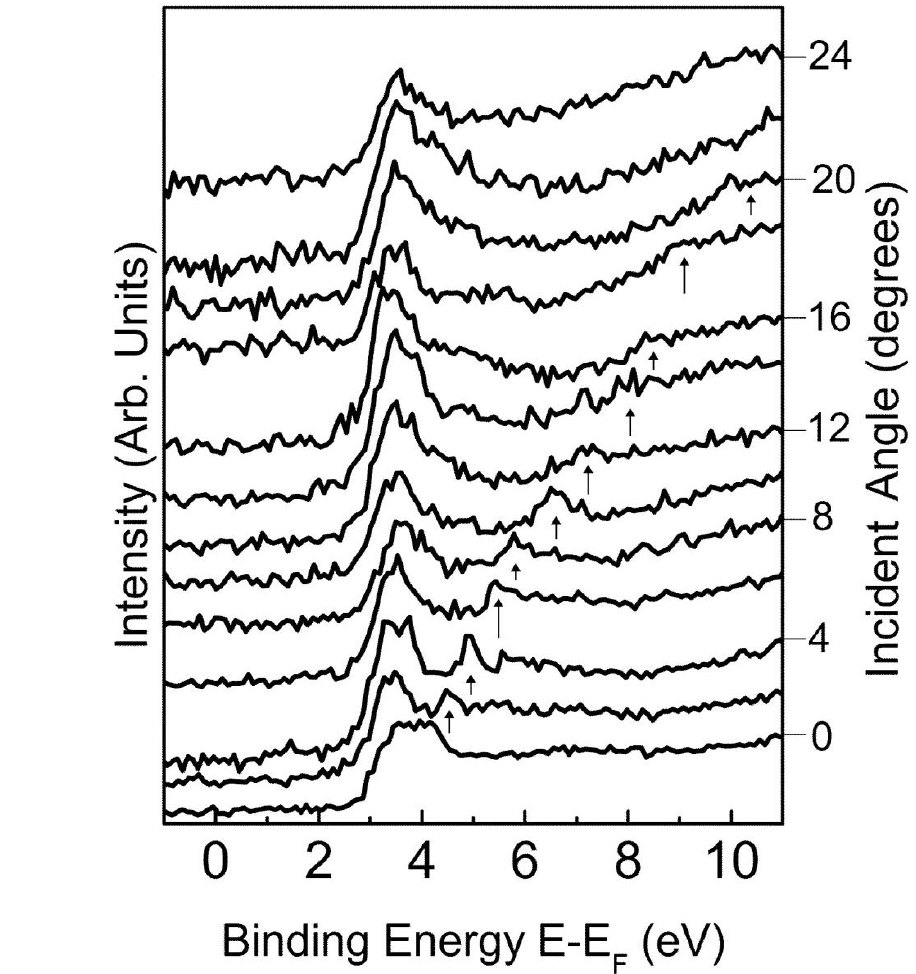
Figure 2. The incidence angle dependent inverse photoemission spectra for the Li B O (110) with increasing incidence angle (wave vector) along the [110] direction. 2 4 7 The image state wave vector dependent (incidence angle) dispersion (see text) is indicated by the arrows. The unoccupied state binding energies are given in terms of E-E . Adapted from F